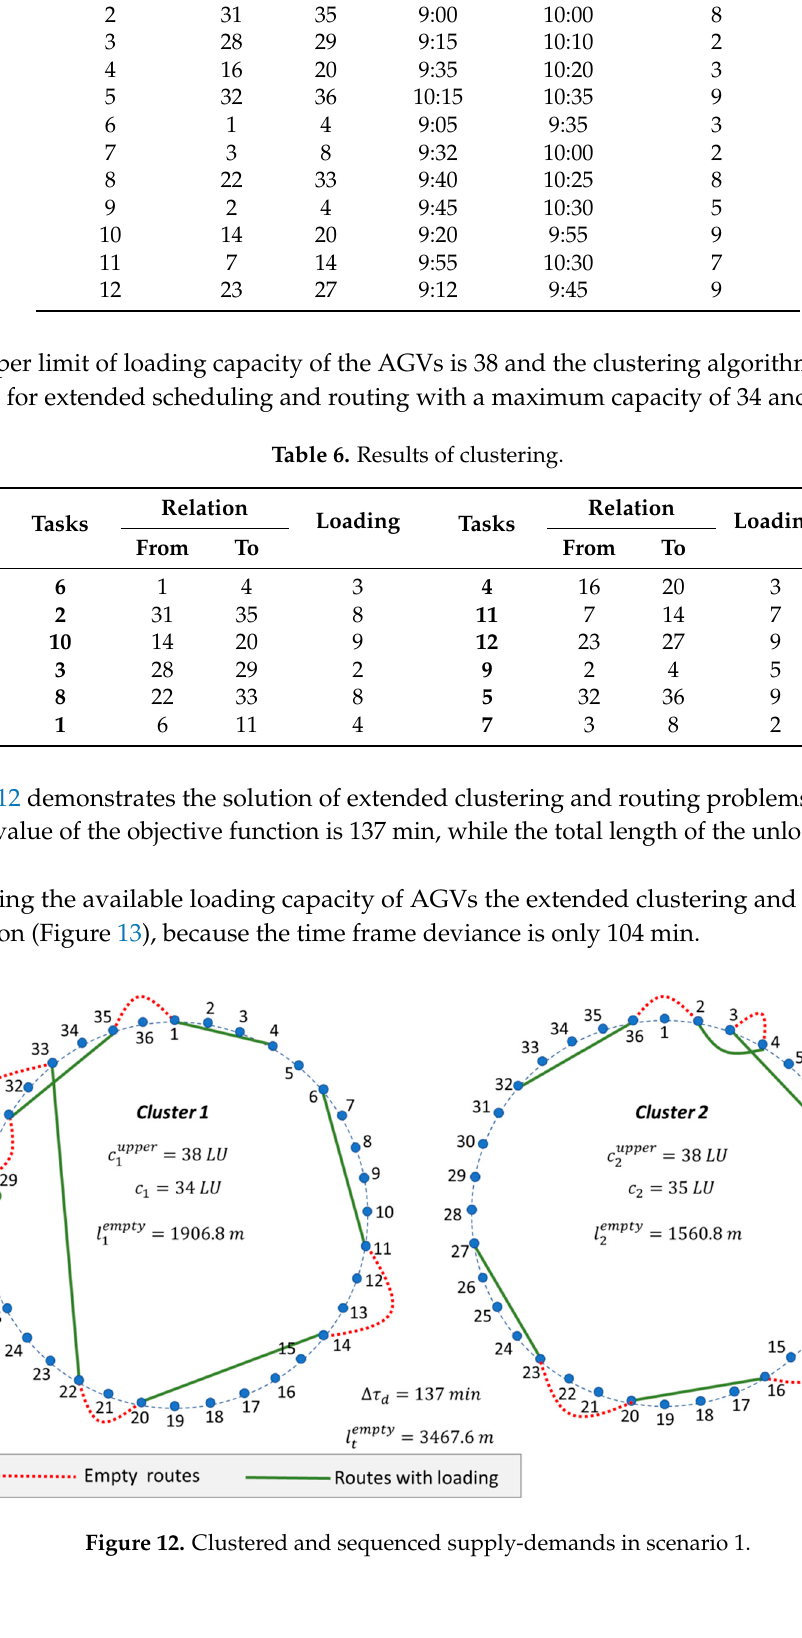
Figure 13. Clustered and sequenced supply-demands in scenario 2. If the objective function of the extended clustering and routing problem is the minimization of the empty routes, then the energy efficiency can be minimized, but the time frame deviance is too high and some supply-demands cannot be performed within the lower and upper limit of the predefined time frame. The minimization of the length of empty routes can be performed in the case of one route, which means that the available loading capacity of AGV must be higher than in the case of scenarios 1 and 2. In the case of scenario three, the total length of the empty routes is 2948.7 m, while the required AGV’s capacity is 69 LU and the total time frame deviance is 192 min. The key functionality of the algorithm has been explained. Figures 14 and 15 show the pseudocode of the algorithm because the details of the software engineering part would be interesting for anyone aiming to replicate the implementation. Input: number of stars, objective function, constraints, sign restrictions, termination criteria Output: optimal clustering //Initialization 1 generate feasible solutions randomly in the n-dimensional search space (30)